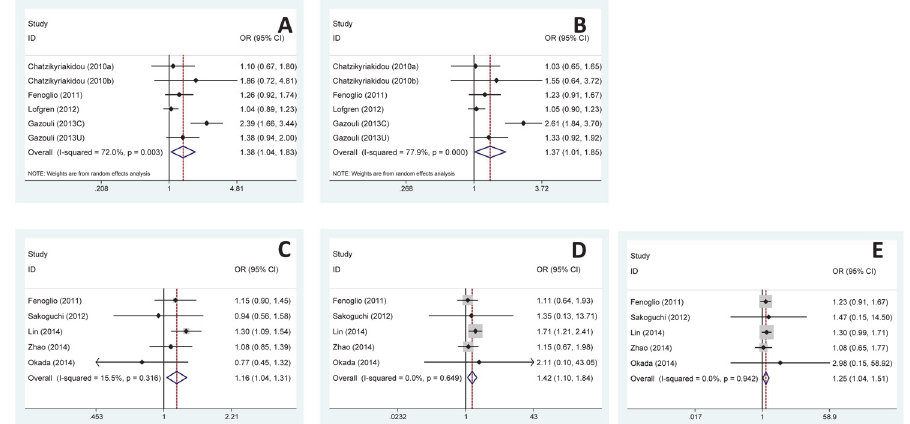
Fig 2. Forest plots of ADs risk associated with rs2910164. (A-B) Forest plots of ADs risk associated with rs2910164 stratified analyzed by ethnicities. (A) Heterozygote model, GC vs GG, Caucasian subgroup, random model. (B) Dominant model, GC+CC vs GG, Caucasian subgroup, random model. (C-E) Forest plots of ADs risk associated with rs2910164 stratified analyzed by diseases. (C) Allele model, C vs G, Other diseases subgroup, fixed model. (D) Homozygote model, CC vs GG, Other diseases subgroup, fixed model. (E) Dominant model, GC+CC vs GG, Other diseases subgroup, fixed model. OR: odds ratio; 95% CI: 95% confidence